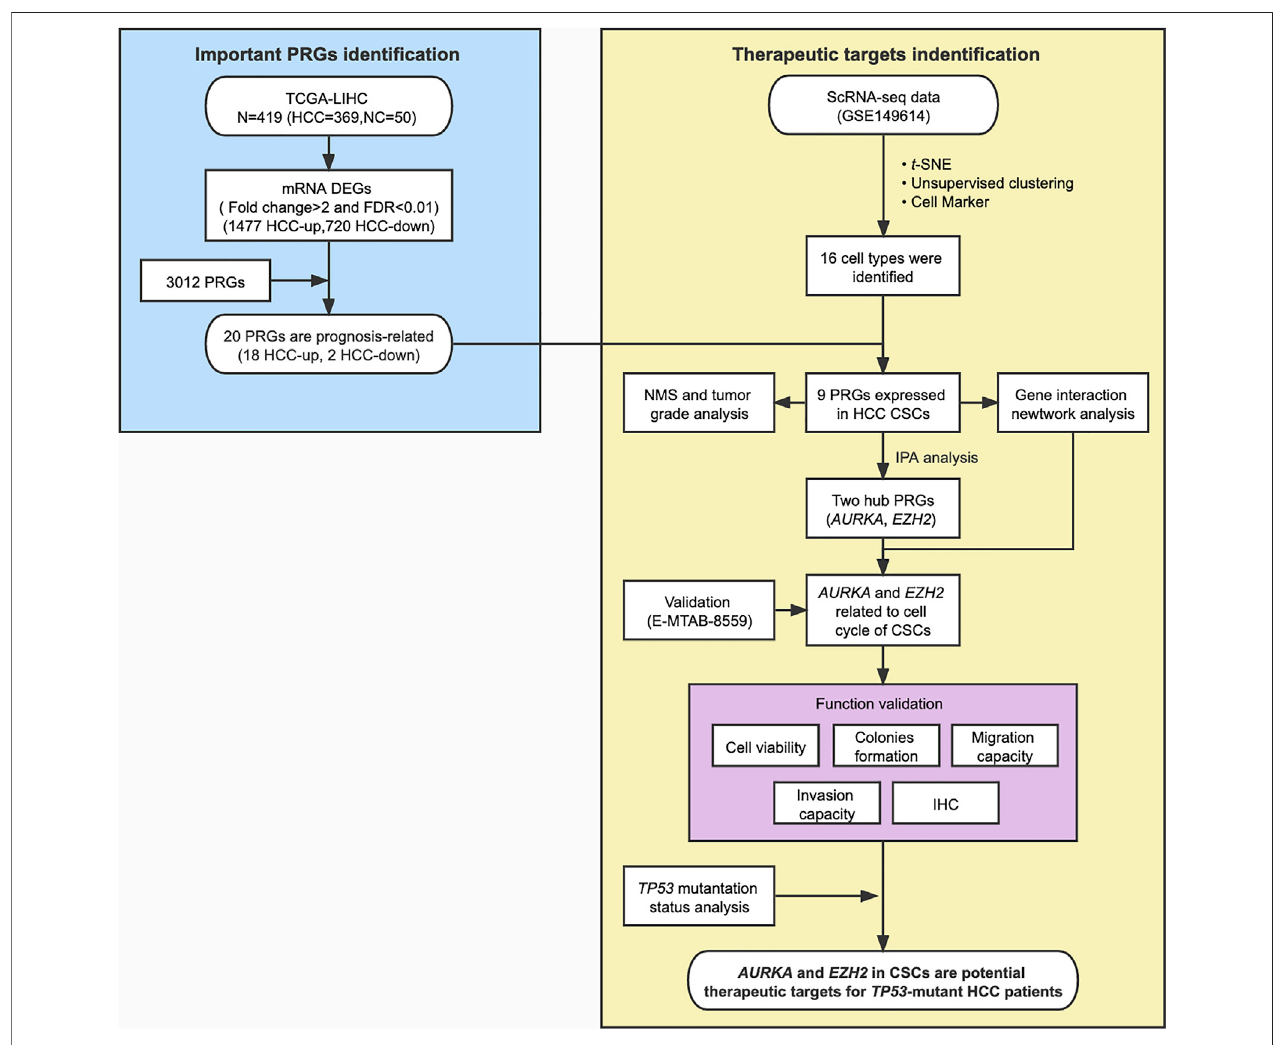
FIGURE 1 | Flowchart for bioinformatics analysis and validation of phosphorylation-related genes (PRGs) based on the TCGA dataset and scRNA-seq data of HCC. NMS, Nodal Metastasis Status; DEGs, differentially expressed genes.